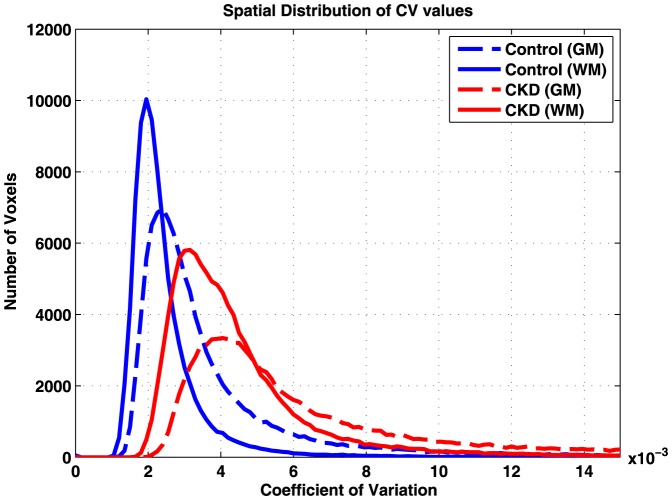
CV histograms in GM (dotted lines) and WM (solid lines) for a representative CKD patient (red) and young healthy control (blue), corresponding to the CV maps shown in Figure 1.GM and WM ROIs were defined using the strict threshold approach.